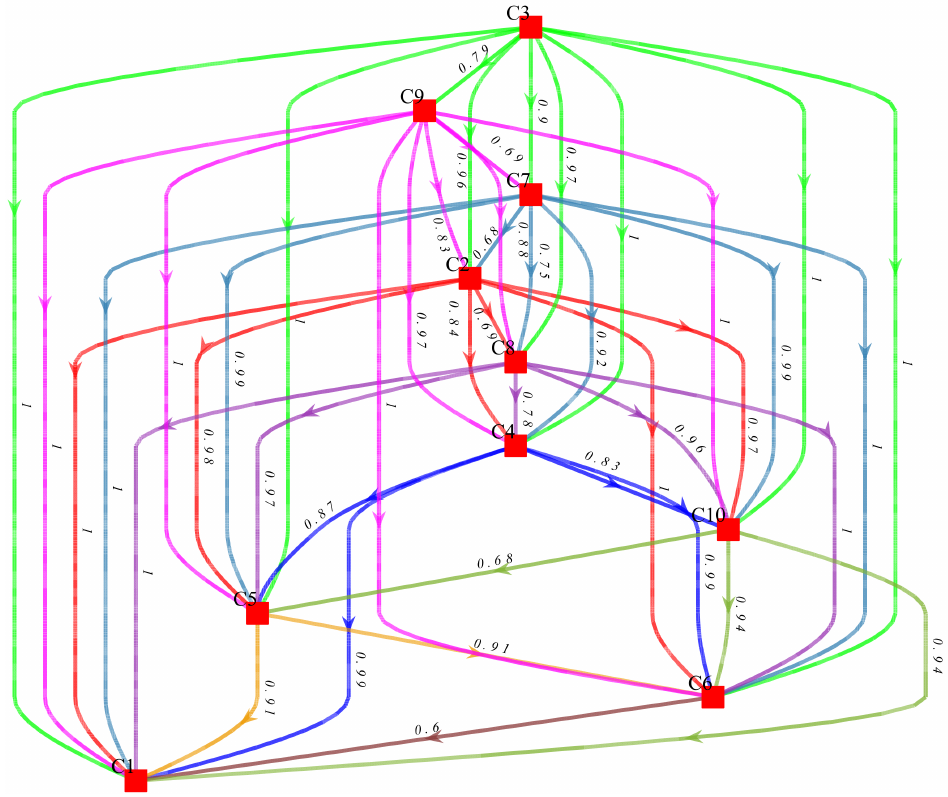
Figure 3. The credal ranking of indicators for the performance evaluation of market-oriented